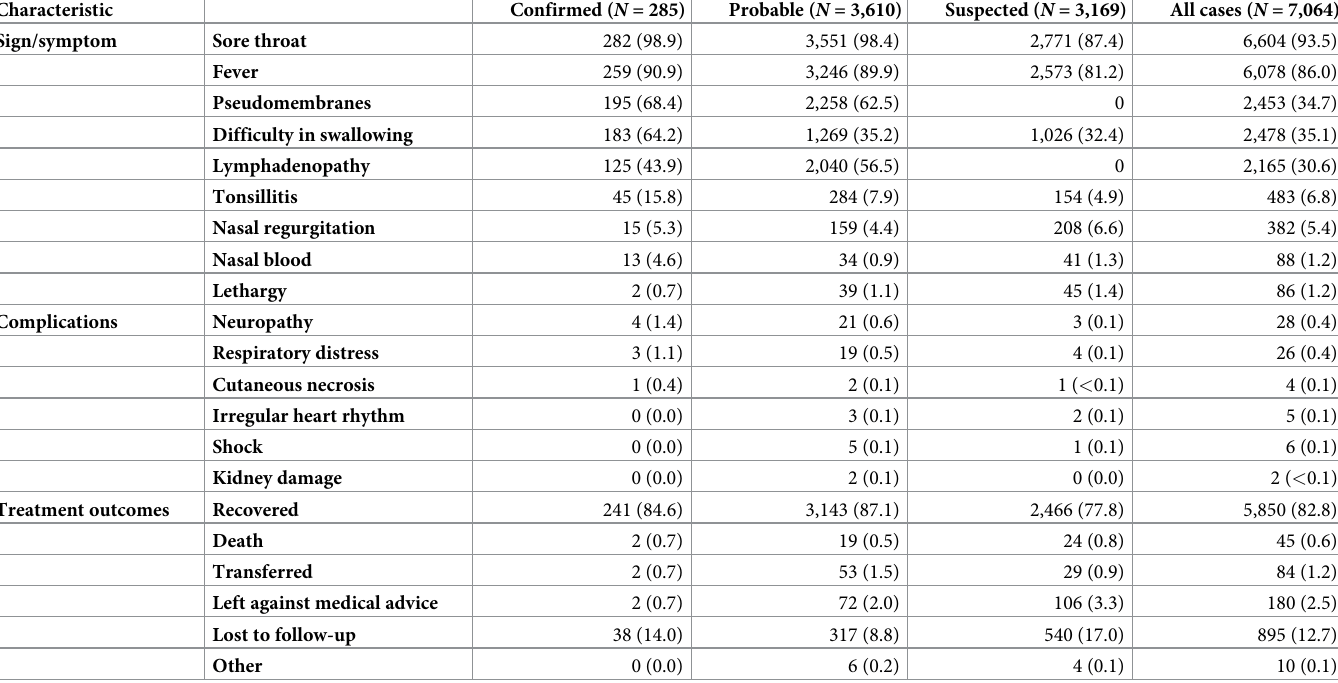
Table 2. Number (%) of signs and symptoms, complications, and treatment outcomes among diphtheria cases, by case definition, among Rohingya refugees, Cox’s Bazar, Bangladesh, November 10, 2017 to November 10, 2019.